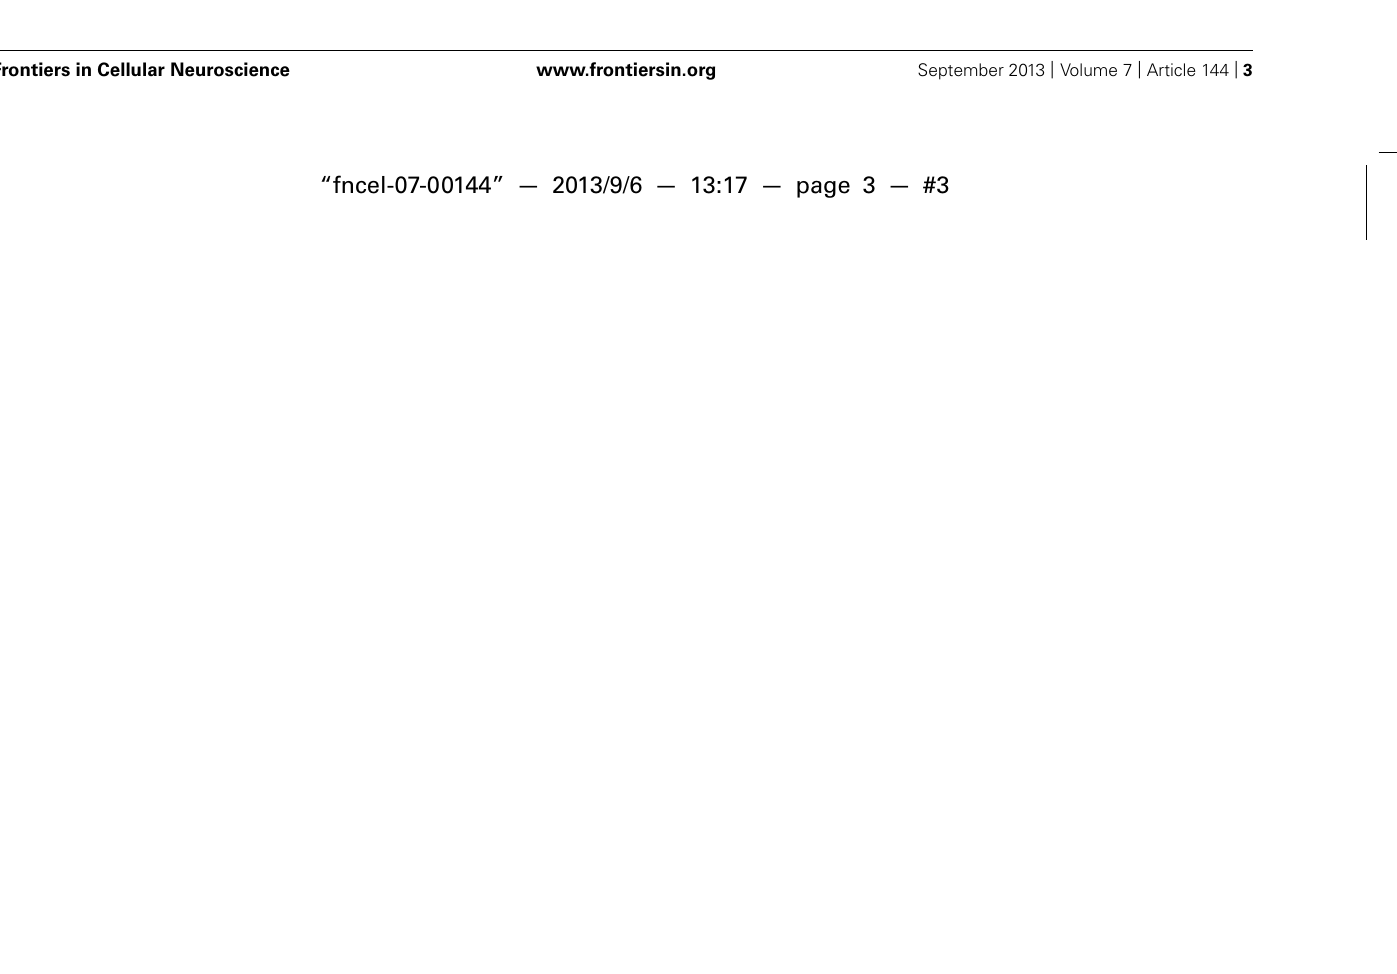
FIGURE 1 | Biosynthesis of fatty acids . Medium- to long chain SFAs are successively transformed by the action of elongases (E) into palmitic acid (16:0), which is then either elongated to stearic acid (18:0), and other long chain SFAs, or desaturated, together with stearic acid (18:0), by Δ 9 desaturase to produce de novo MUFAs of the n-7 and n-9 series, such as palmitoleic acid (16:1) and oleic acid (18:1). In the case of PUFAs, Δ 6 and Δ 5 desaturases work cooperatively with elongases to introduce double bonds and extend the aliphatic chain in a successive manner, from ALA (18:3 n-3) to EPA (20:5 n-3) in the n-3 series, and from LA (18:2 n-6)